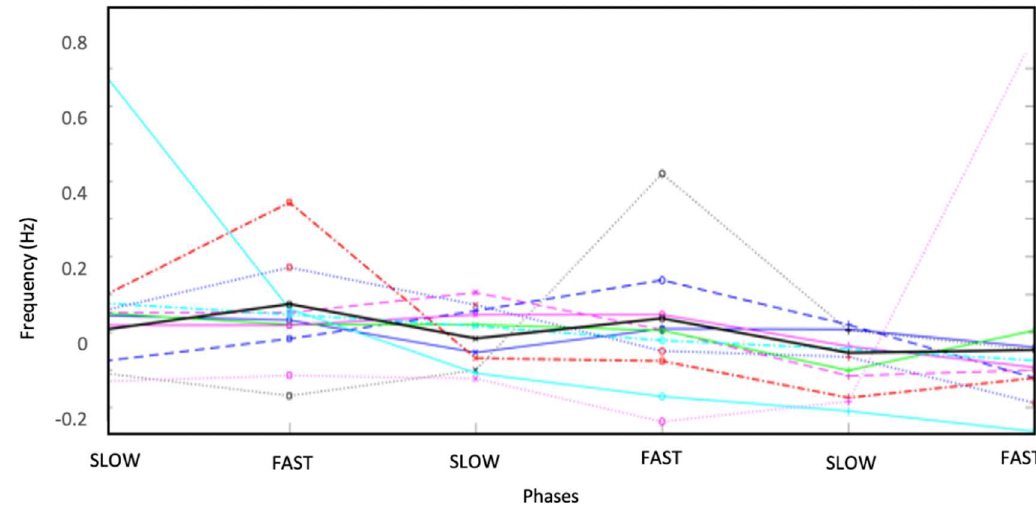
16 of 25 Figure 10. Top plot: Breathing frequency of the virtual human during a single pilot trial. Bottom plot: Example breathing recording from a human participant. Findings Twelve university students participated in the pilot study (10 males and 2 females). The participants were contacted via emails. To assess the influence of the VH breathing behaviour on the participants, we calculated the participants’ breathing frequency for each of the six phases of the trial